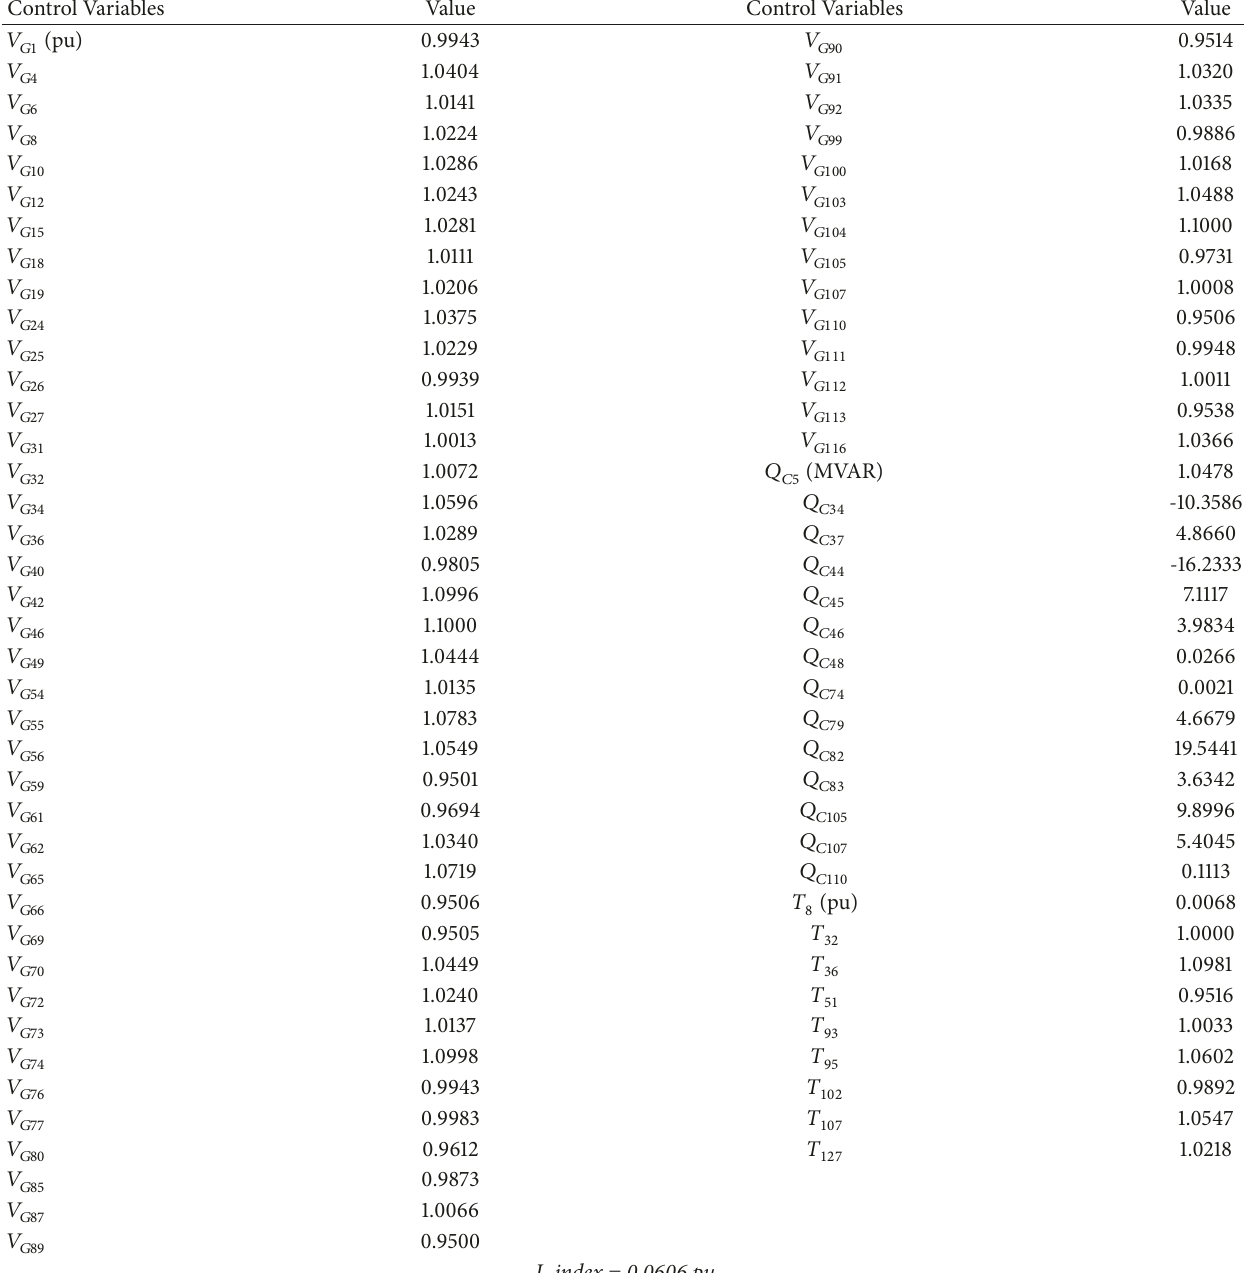
Table 17: Optimal solution obtained by MSFS for the IEEE 118-bus power system with minimization of L-index. Control